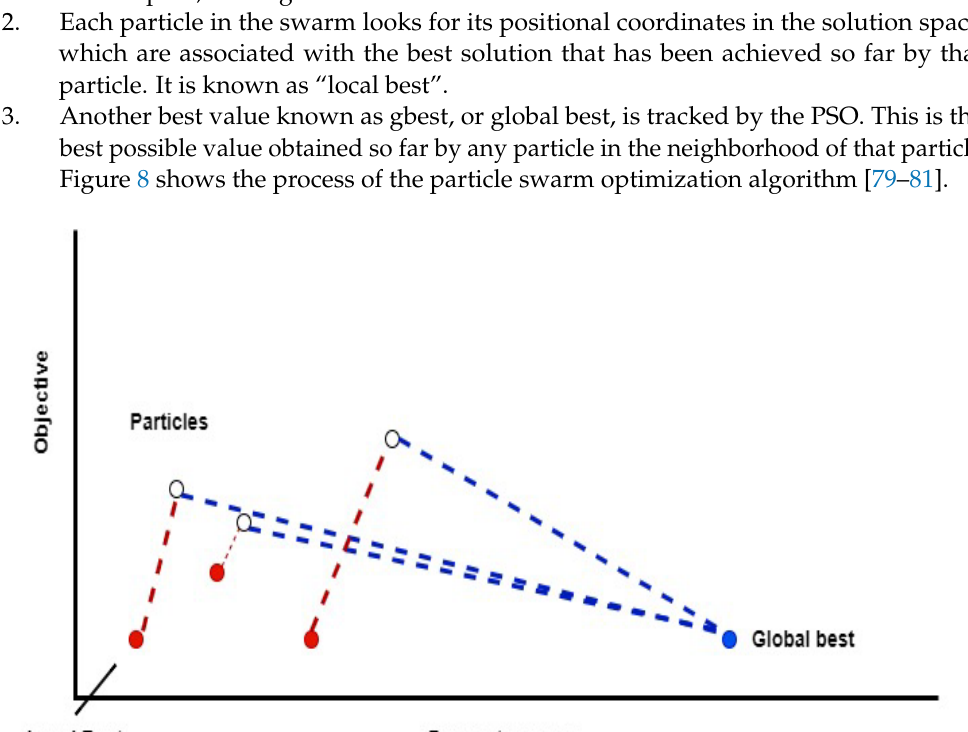
Figure 8. Process of particle swarm optimization Algorithm.